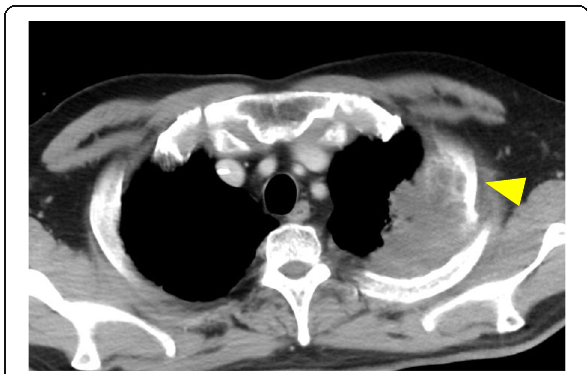
Fig. 1 Thoracic CT scan. CT revealing an 80 × 60 mm mass lesion at the left upper lobe, which invaded the second rib